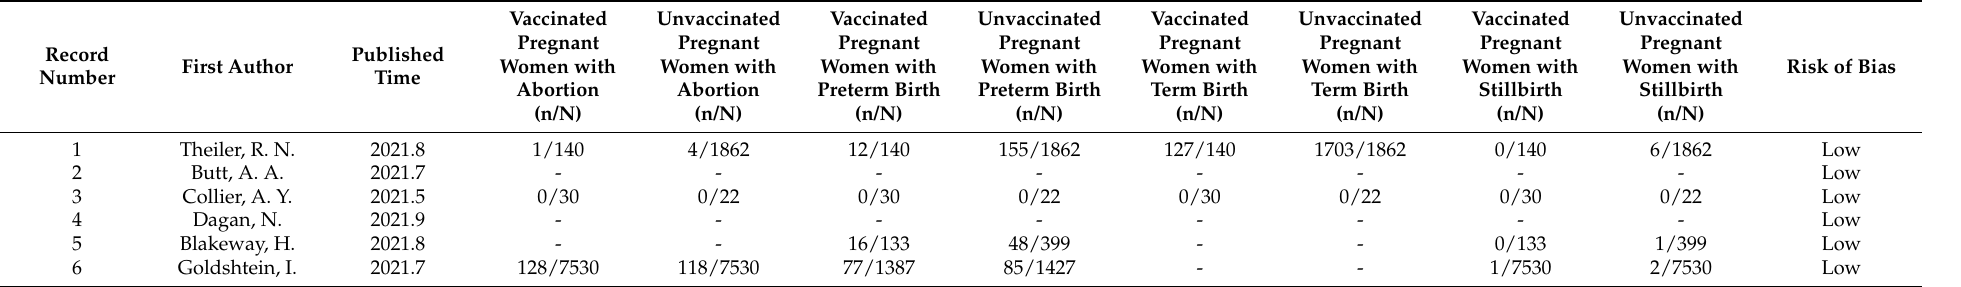
Table 3. Findings of included original studies for fetal outcomes.